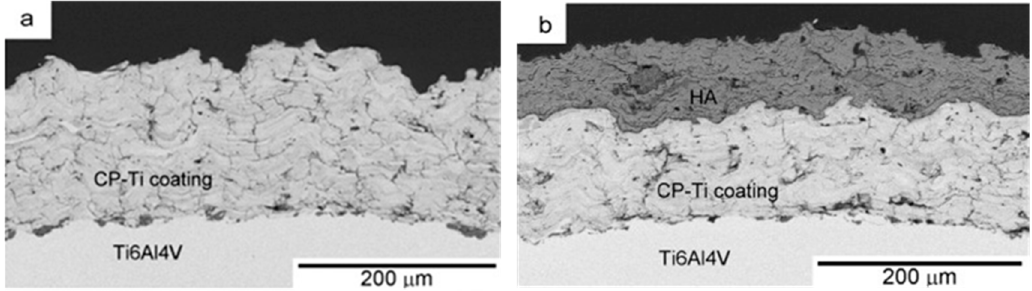
Figure 6. Cross-sectional electron backscatter diffraction (EBSD) images of the ( a ) CP-Ti and ( b ) HA coating on the CP-Ti [50]. Reprinted with permission from reference [50] 2013 Elsevier.